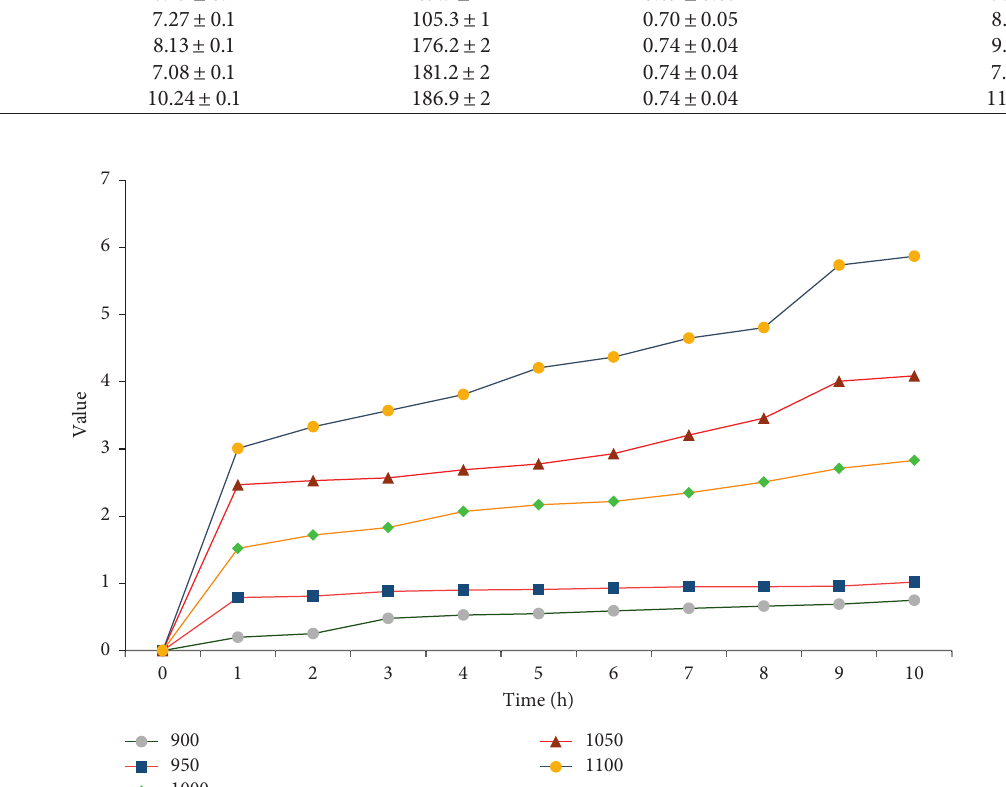
Figure 4: Oxidation of alumina at different